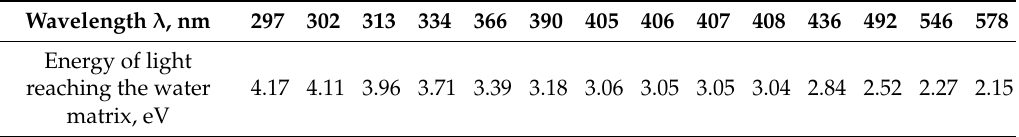
Table 5. Energy values of individual wavelengths emitted by the UV